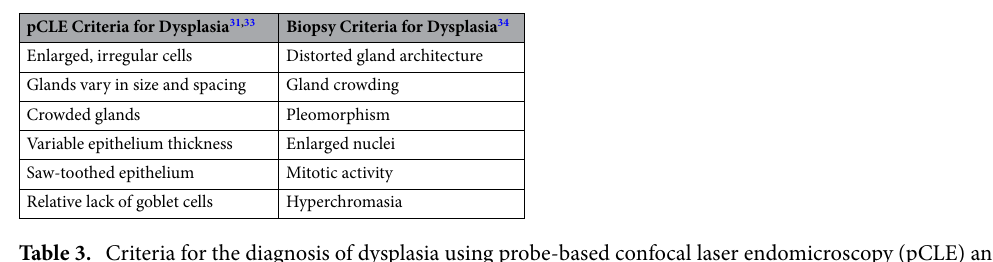
Table 3. Criteria for the diagnosis of dysplasia using probe-based confocal laser endomicroscopy (pCLE) and hematoxylin-and-eosin-stained